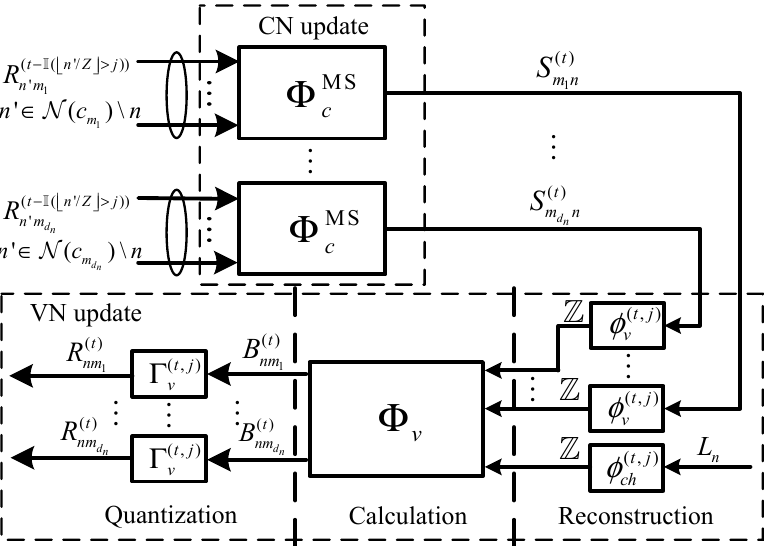
Figure 1. The decoding architecture of the layer-specific MIM-QSMS decoder